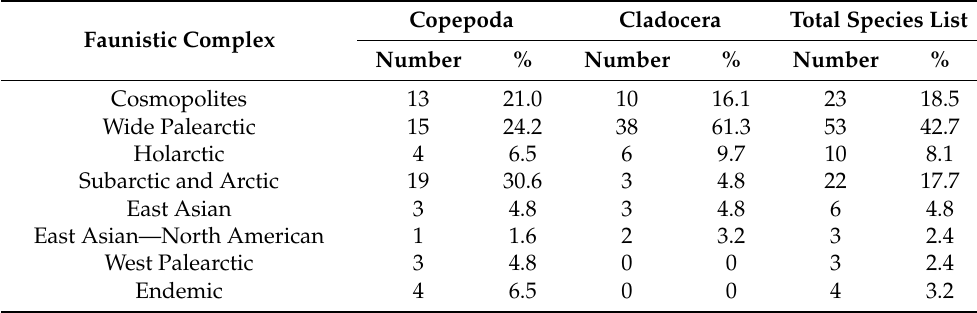
Table 7. Biogeographical structure of microcrustacean fauna of Putorana Plateau. Copepoda Cladocera Total Species List Faunistic Complex Number